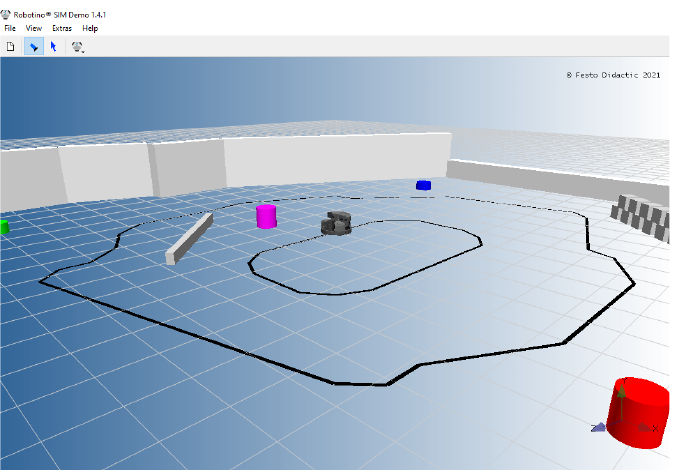
Figure 3. Three-dimensional view of RobotinoSIM.